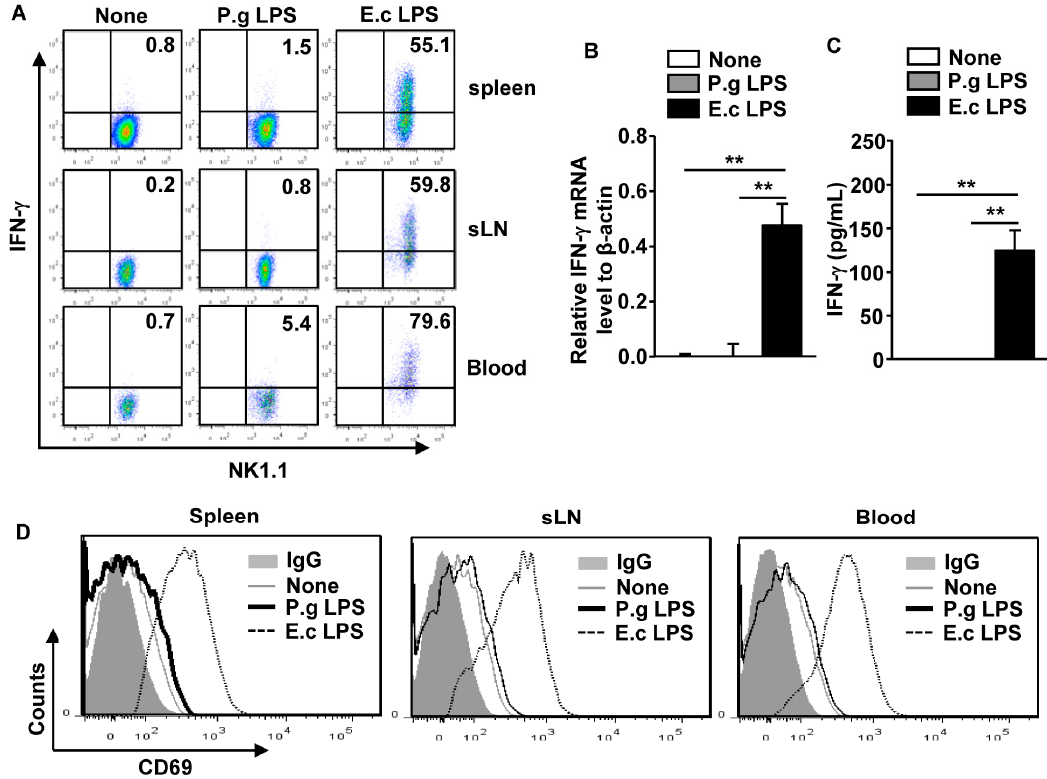
Figure 2. P. gingivalis LPS did not upregulate IFN- γ production and CD69 expression in the spleen and sLN NK cells. C57BL/6 mice were injected i.v. with 1 mg/kg of P.g LPS or E.c LPS. Six hours after injection, splenocytes were further cultured with monensin solution for 4 h. ( A ) Intracellular IFN- γ production levels in the CD3 − NK1.1 + cells in the spleen, sLNs, and blood were analyzed by flow cytometry; ( B ) C57BL6 mice were treated with the LPS for 6 h; subsequently NK cells were isolated from the spleen. The mRNA levels of IFN- γ were measured in the spleen NK cells; ( C ) Isolated NK cells were further incubated in the culture medium for 4 h. The IFN- γ concentration in the cultured medium was measured by ELISA; ( D ) The CD69 expression level in the spleen, sLN, and blood NK cells were analyzed 6 h after LPS treatment. All data are representative or the average of analyses of six samples from three independent experiments. ** p < 0.01.